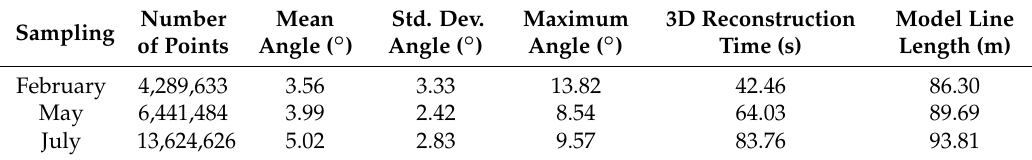
Table 2. Statistics of the performance of drift correction method for the 105 m length row.